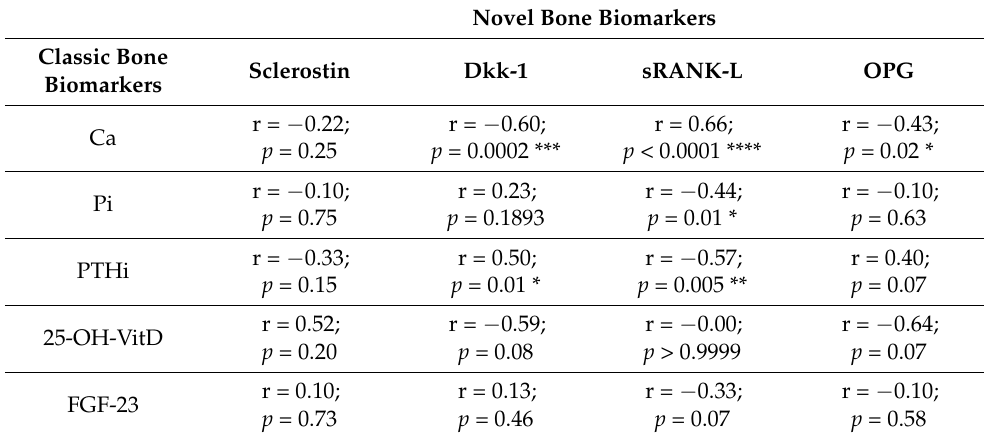
Table 2. Correlation between novel bone biomarkers and classic bone biomarkers.